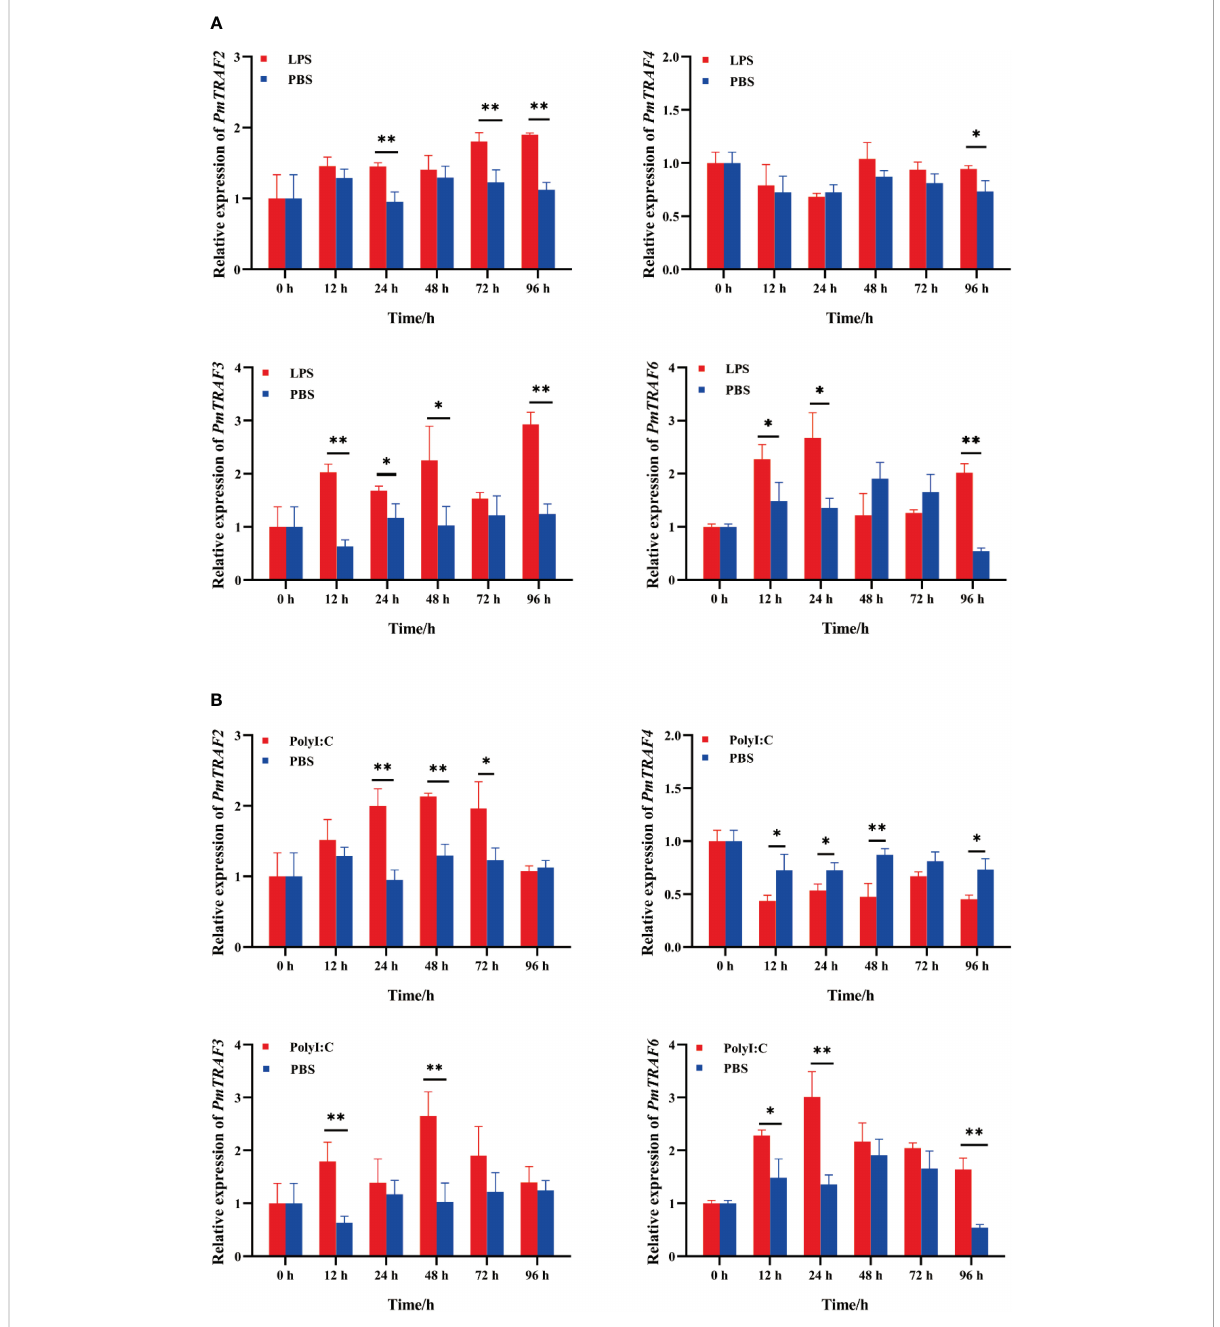
FIGURE 5 The mRNA expression of PmTRAFs in hepatopancreas after LPS challenge (A) and PolyI:C challenge (B) . Relative expression was expressed as the mean ± S.D. (n = 5). Signi fi cant differences in relative expression levels between two groups at the same time point are denoted by asterisks: ** p < 0.01; * p <